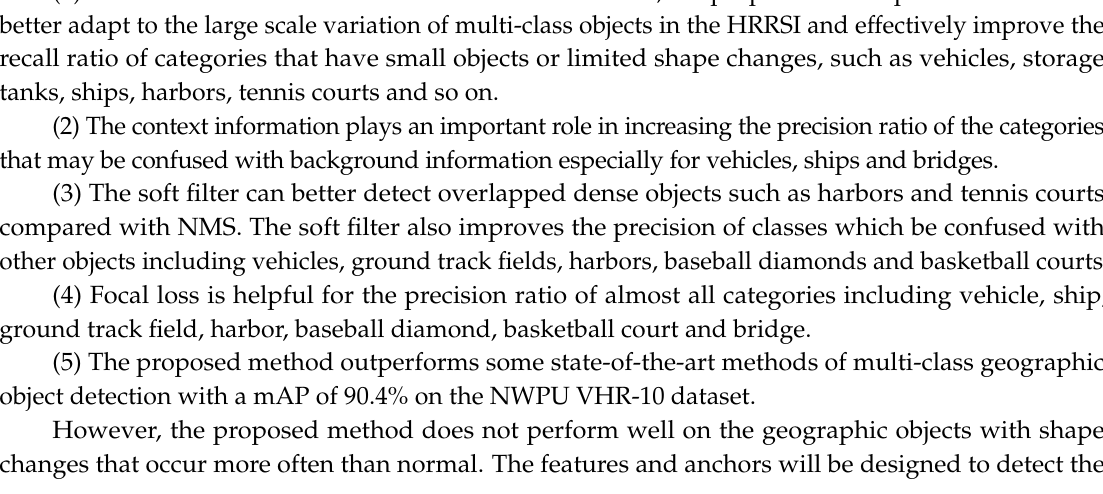
N on the AP. (b) The t N on the recall ratio. s